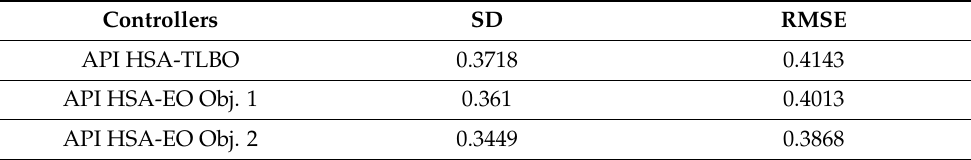
Table 7. Statistical analysis of the active power—normal third